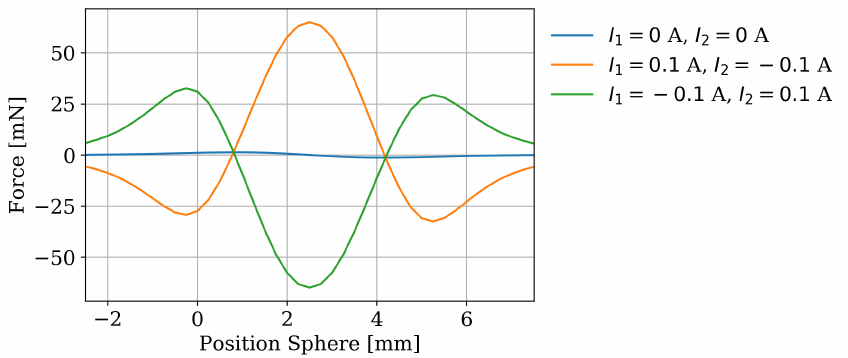
Figure 6. The vertical electromagnetic force acting on the spherical magnet, plotted over its position. Each combination of coil currents is shown as a single line. The catch-actuator’s vertical symmetry induces a symmetric force for equal but opposed currents.